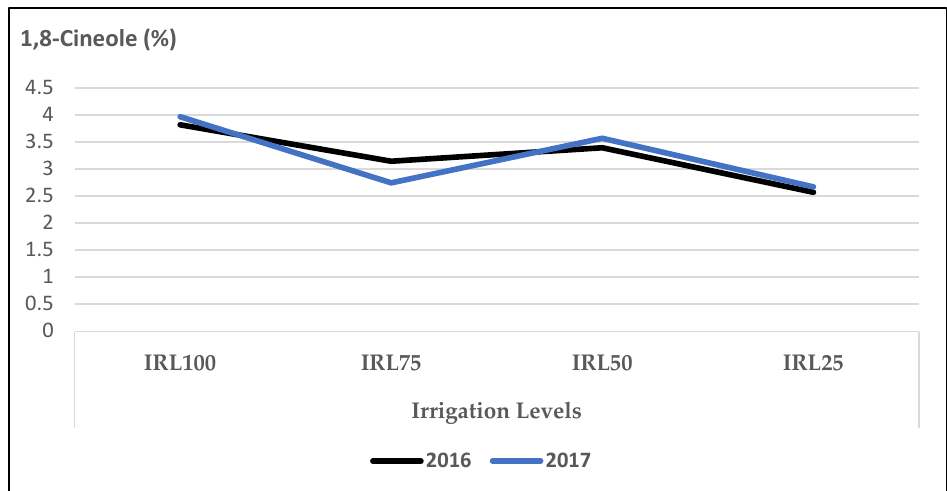
Figure 2. Mean values of 1,8-cineole (%) at different IRLs of O. basilicum L. essential oil; IRL 100 = 100% FC; IRL 75 = 75% FC; IRL 50 = 50% FC; IRL 25 = 25% FC without SM.